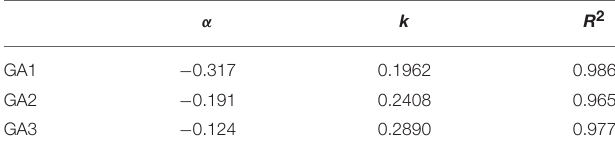
TABLE 2 | Estimated power-law parameters for the variation of polydispersity with galactomannan acetate concentration for GA1, GA2, and